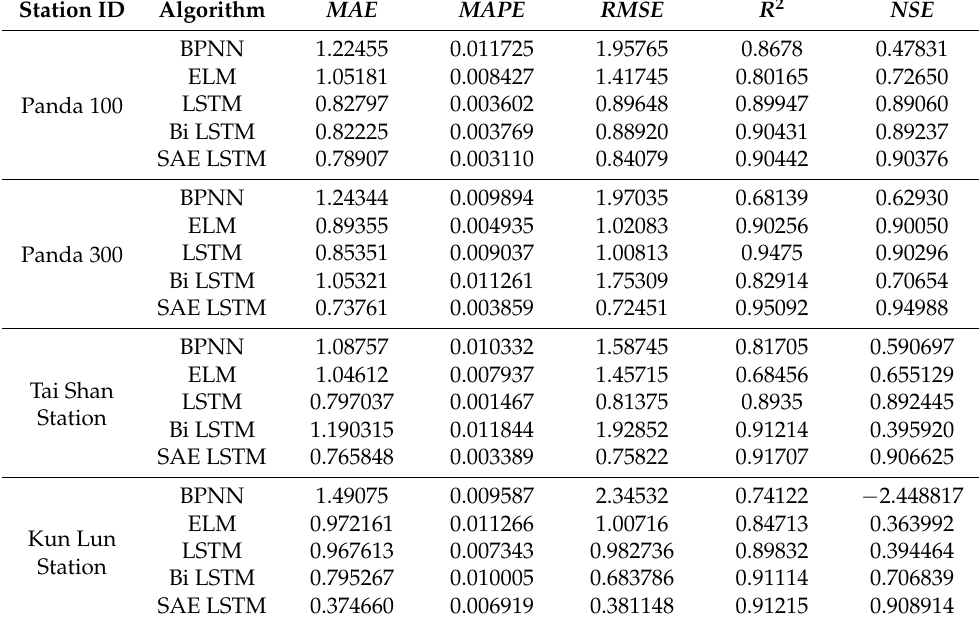
Table 5. One-hour wind speed performance results from station Panda 100 to Kun Lun station.